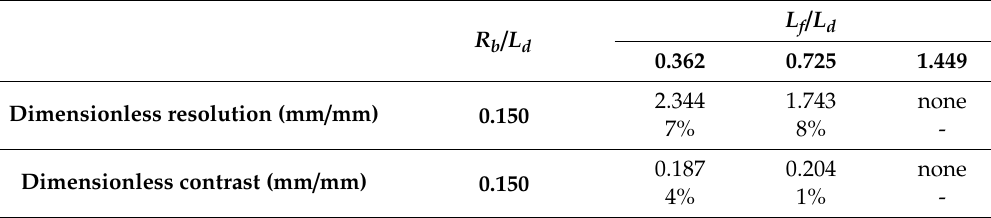
Figure 18. MTF of the experimental results. Table 6. Image quality in the experimental results according to changes in 𝐿 𝑓 /𝐿 𝑑 .